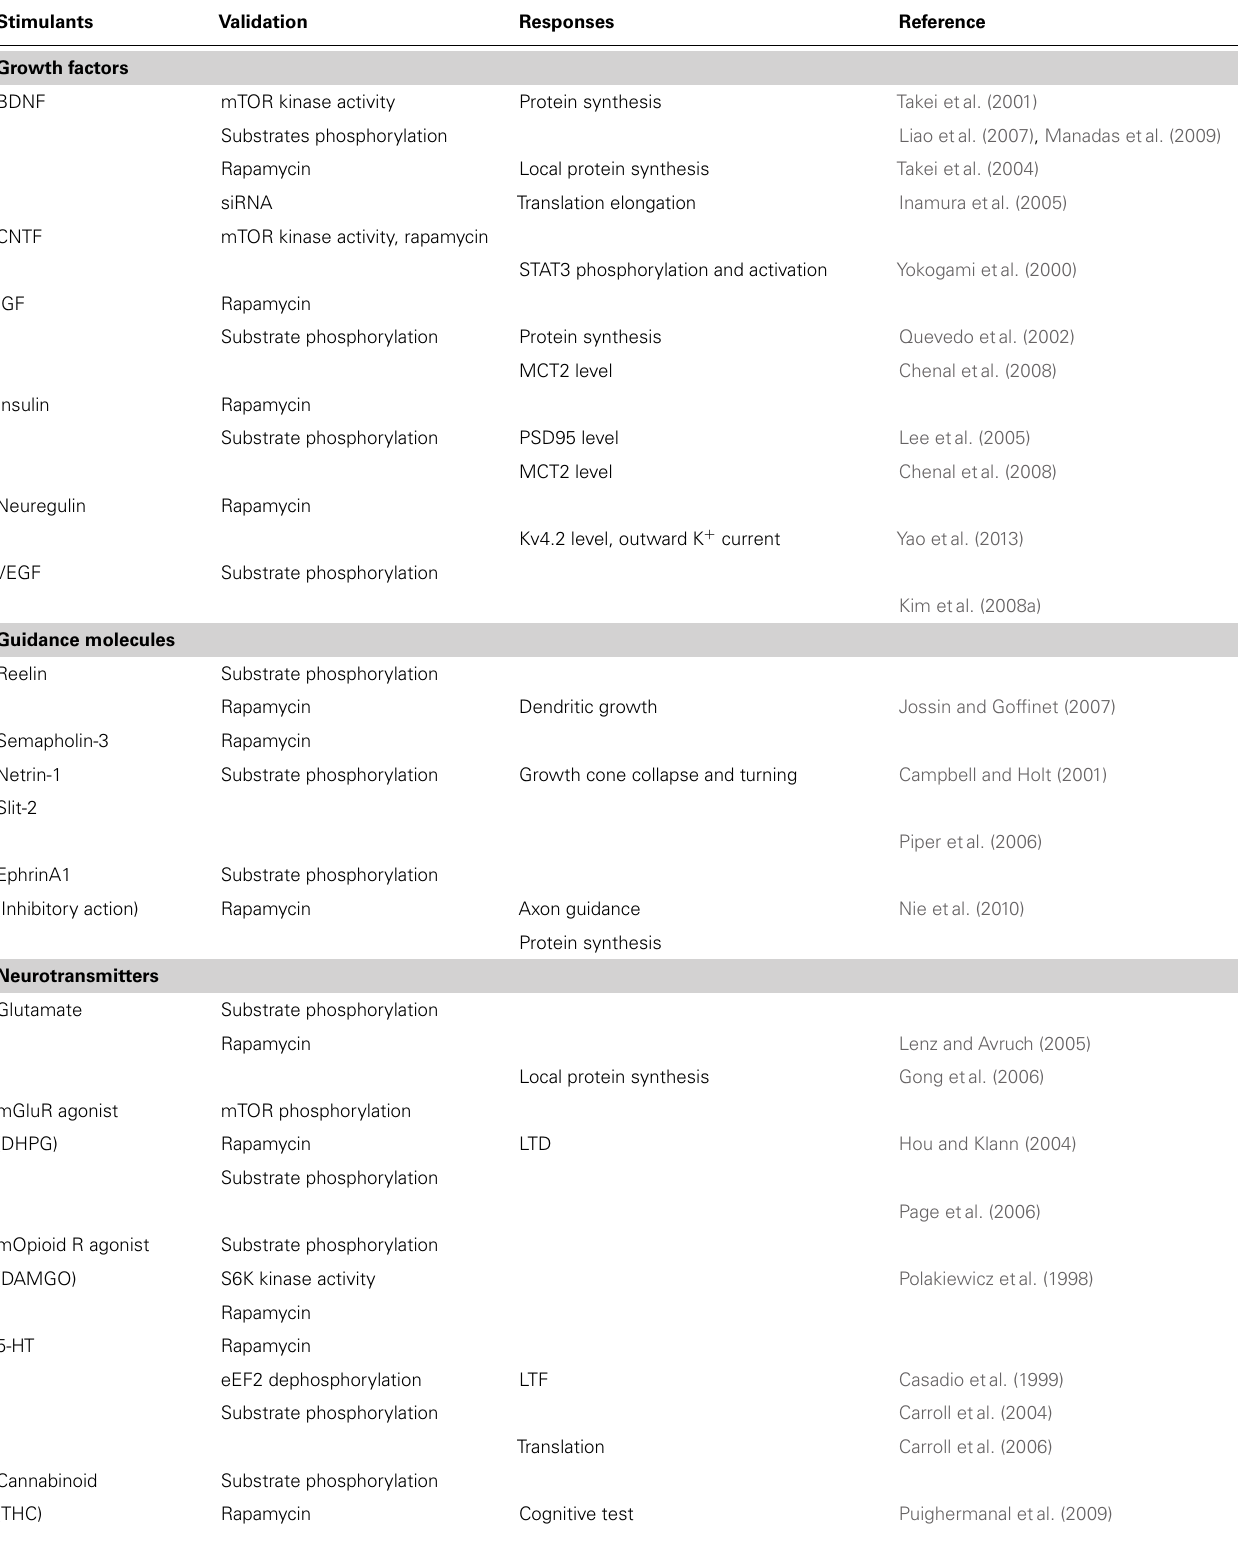
Table 1 | Stimulants of mTOR in CNS